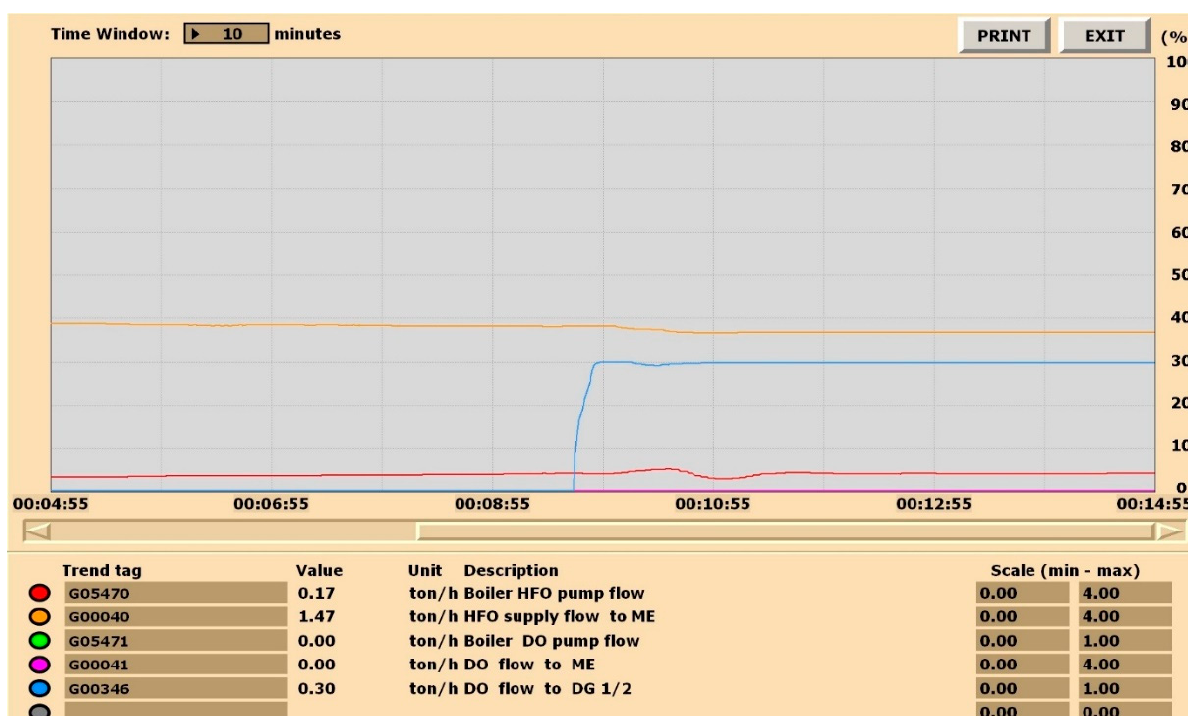
Figure 2. Fuel flows for mode 1.2.